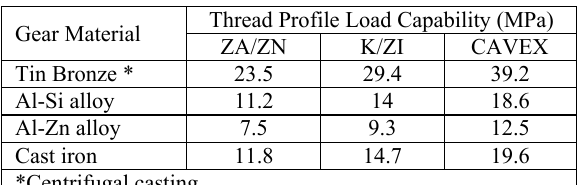
Table B1 Load Capability of Steel Worm Profiles, [2, p.